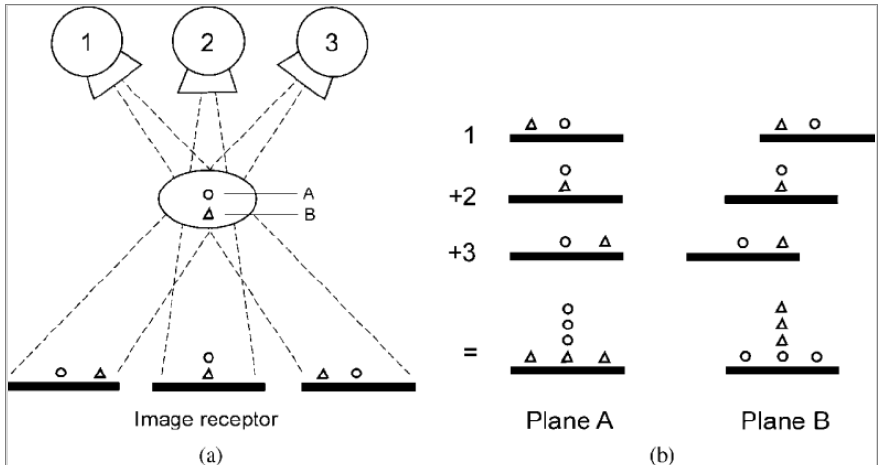
Figure 2. Principles of tomosynthesis image acquisition and SAA reconstruction. (a) Tomosynthesis imaging. The circle in plane A and triangle in plane B are projected in different locations when imaged from different angles. (b) The acquired projection images are appropriately shifted and added to bring either the circle or triangle into focus; structures outside the plane of focus are subsequently spread across the image (i.e., blurred). Figure adapted from Dobbins III and Godfrey